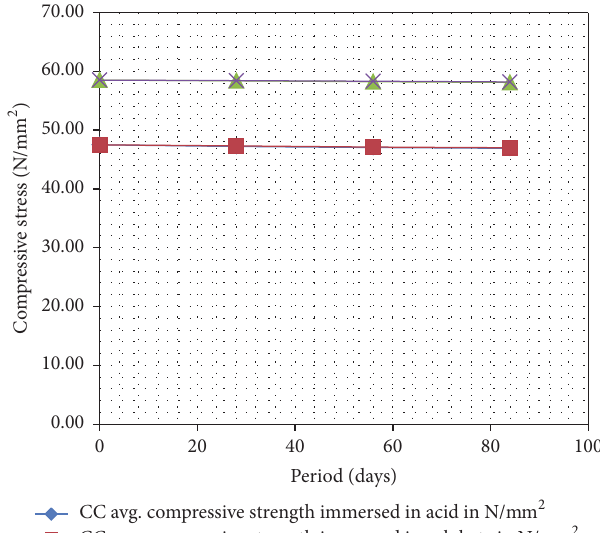
Figure 10: Acid and sulphate